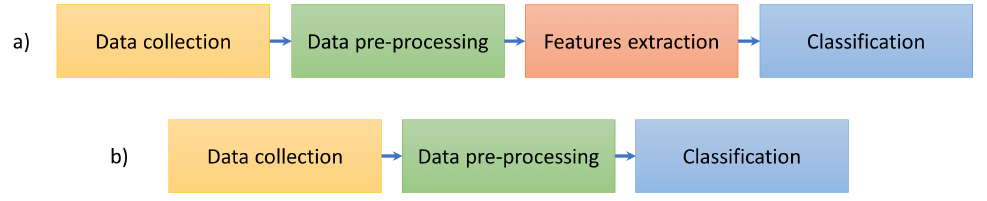
Figure 1. The structure of proposed mental stress recognition approach ( a ) using machine learning ( b ) using deep